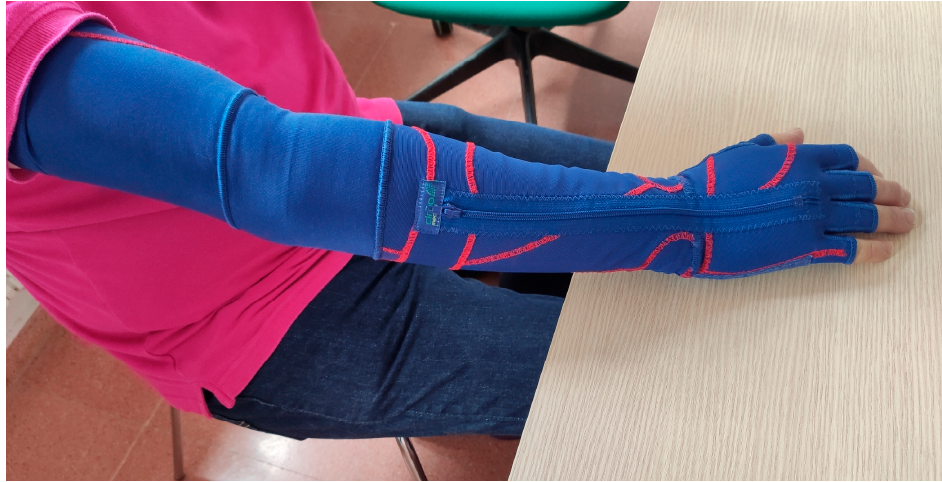
Figure 1. DEFO implemented in a patient with PD.